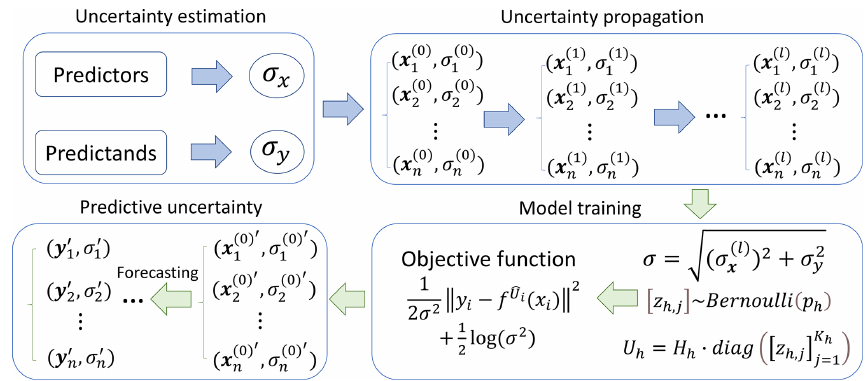
Figure 2. The proposed integrated data–model uncertainty modeling framework in precipitation forecasting. σ x and σ y are the predictor and predictand uncertainty, respectively. x l n and σ l n represent the propagated data value and uncertainty, respectively, for the l th network